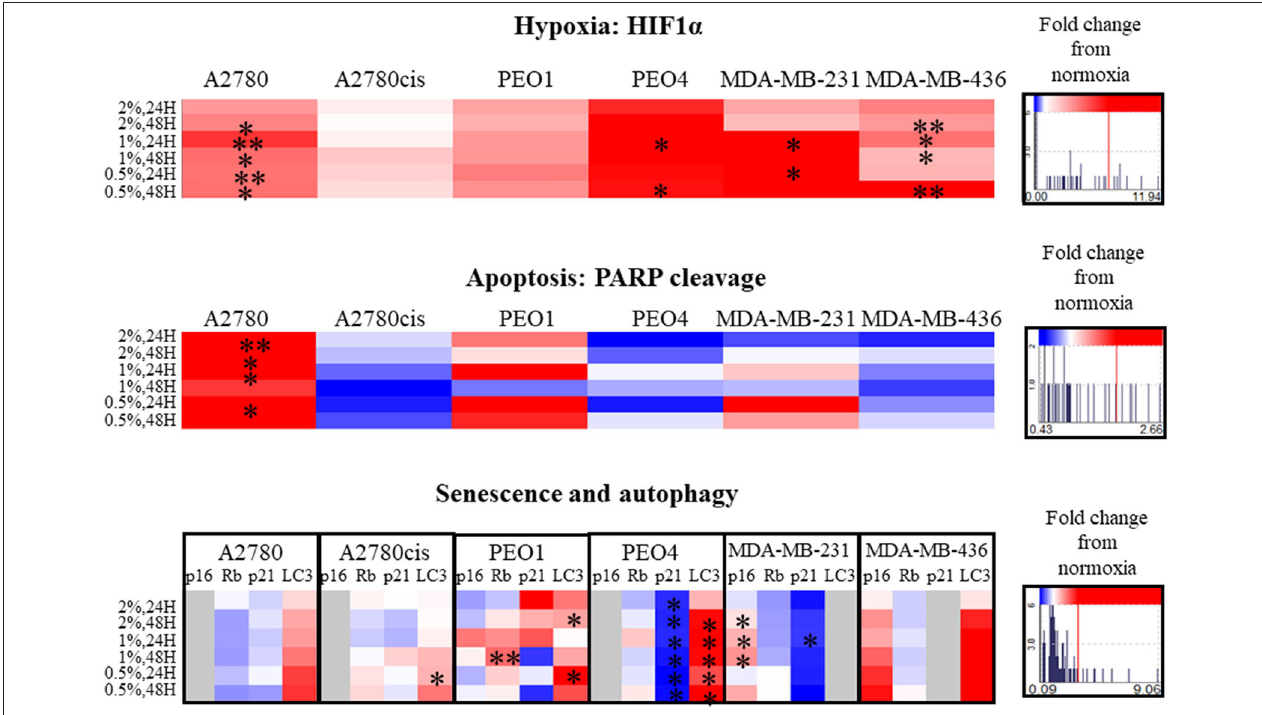
FIGURE 4 | Hypoxia alters apoptosis, senescence and autophagy specifically. Protein expression of HIF1 α , PARP, p16, p21, Rb, and LC3 as determined by densitometry (Image J)(Western blots are shown in Figure S4 ). Each condition was carried out on three biological replicates ( n = 3). Significant changes are starred: * P ≤ 0.05; ** P ≤ 0.01 ( T -test). The histograms on the right side of the figure are indicating increasing (in red) and decreasing (in blue) trends in hypoxia, apoptosis, senescence and autophagy markers in hypoxia conditions comparing to